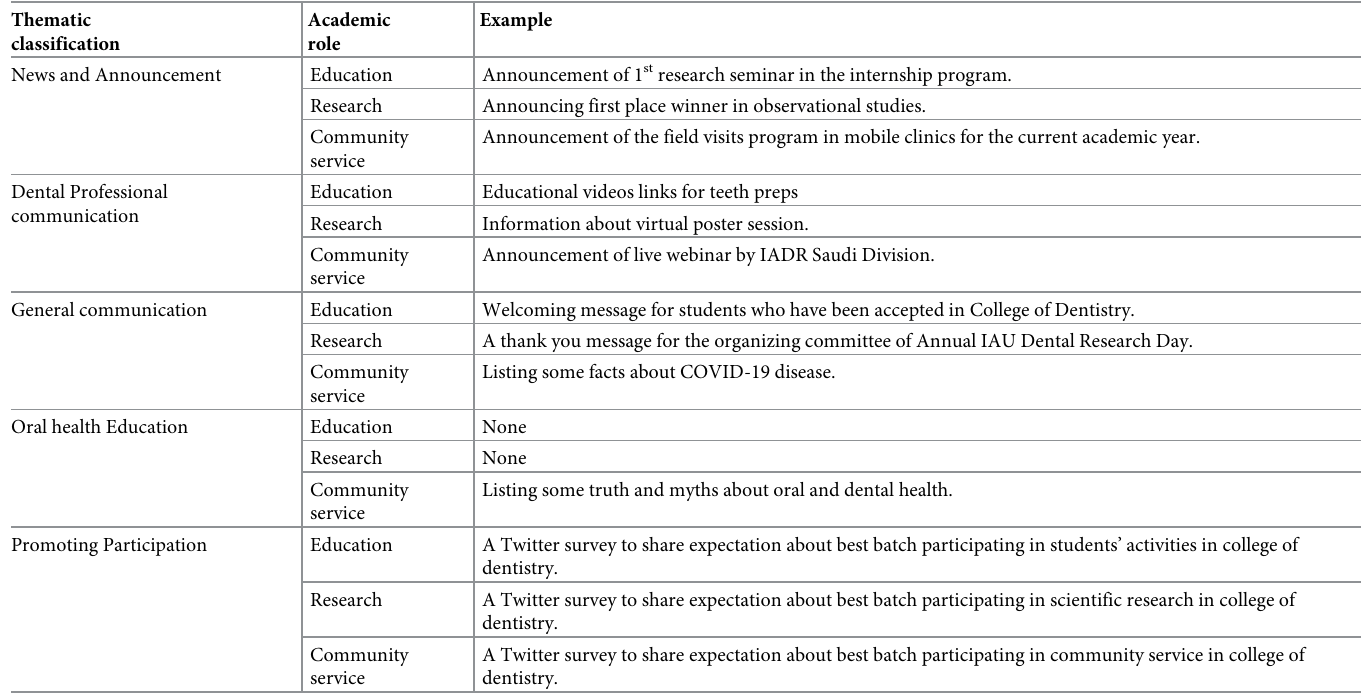
Table 1. Examples for thematic classification and academic role of dental schools’ tweets. Thematic